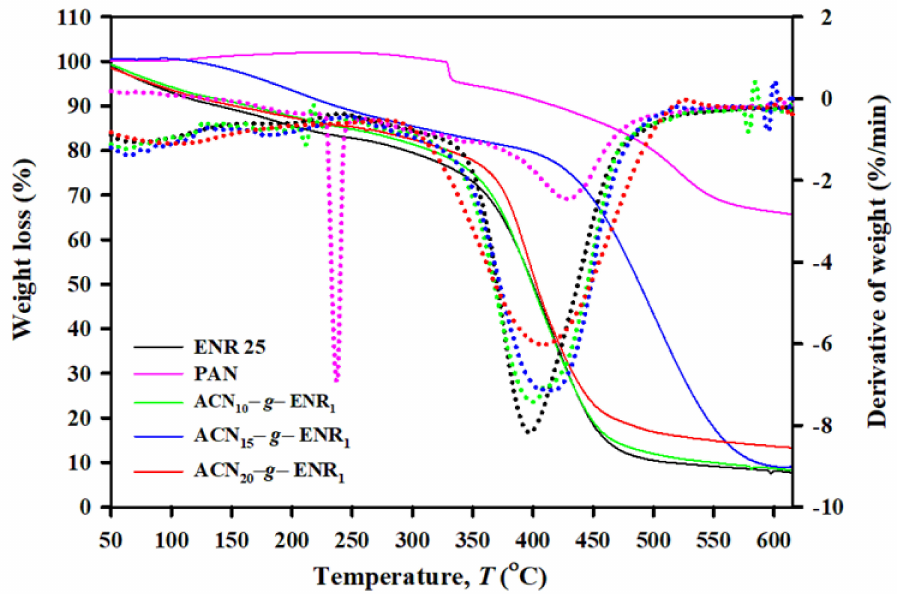
Figure 8. TGA and DTG curves of ENR- 25, PAN, and ACN- g -ENR products at various mole ratios (TGA curves (represented by line) and DTG curves (represented by dotted